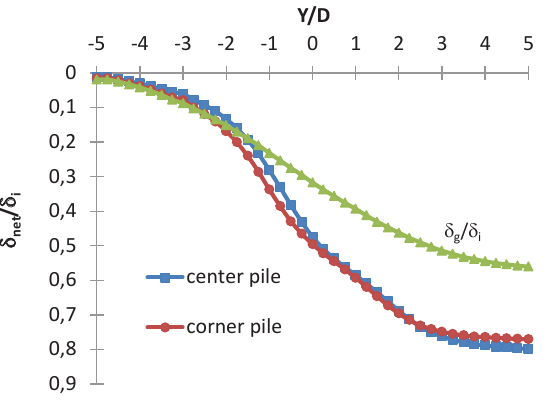
Fig. 8 Distributions of normalized net pile head and soil surface settlement with tunnel advancement for group pile 3 x 3 (analysis IV and G).